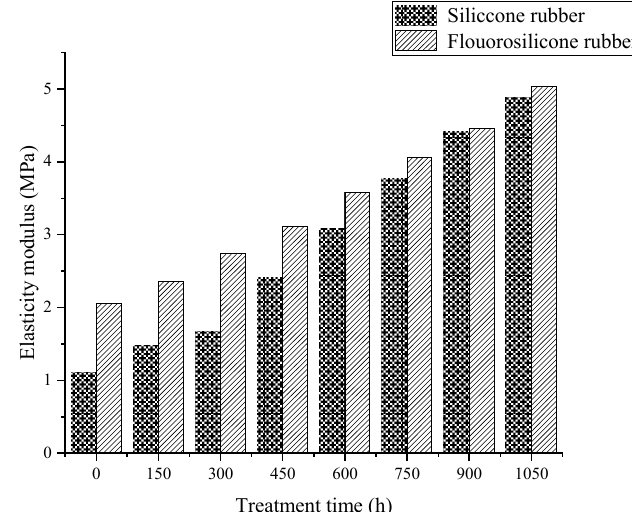
Figure 7. The variation of elasticity modulus with low temperature freezing time.